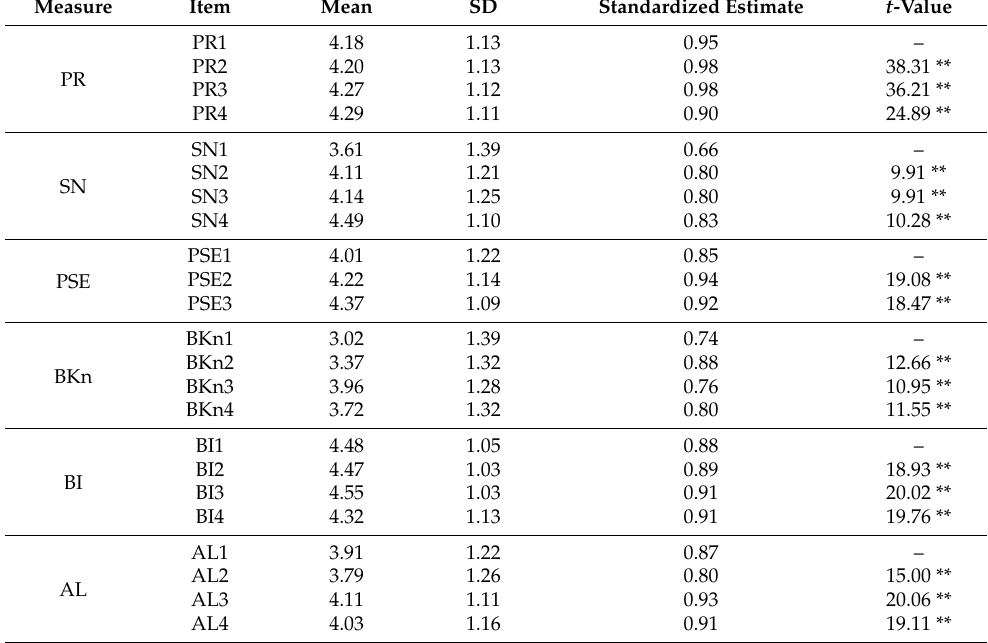
Table 1. CFA results ( n = 211).